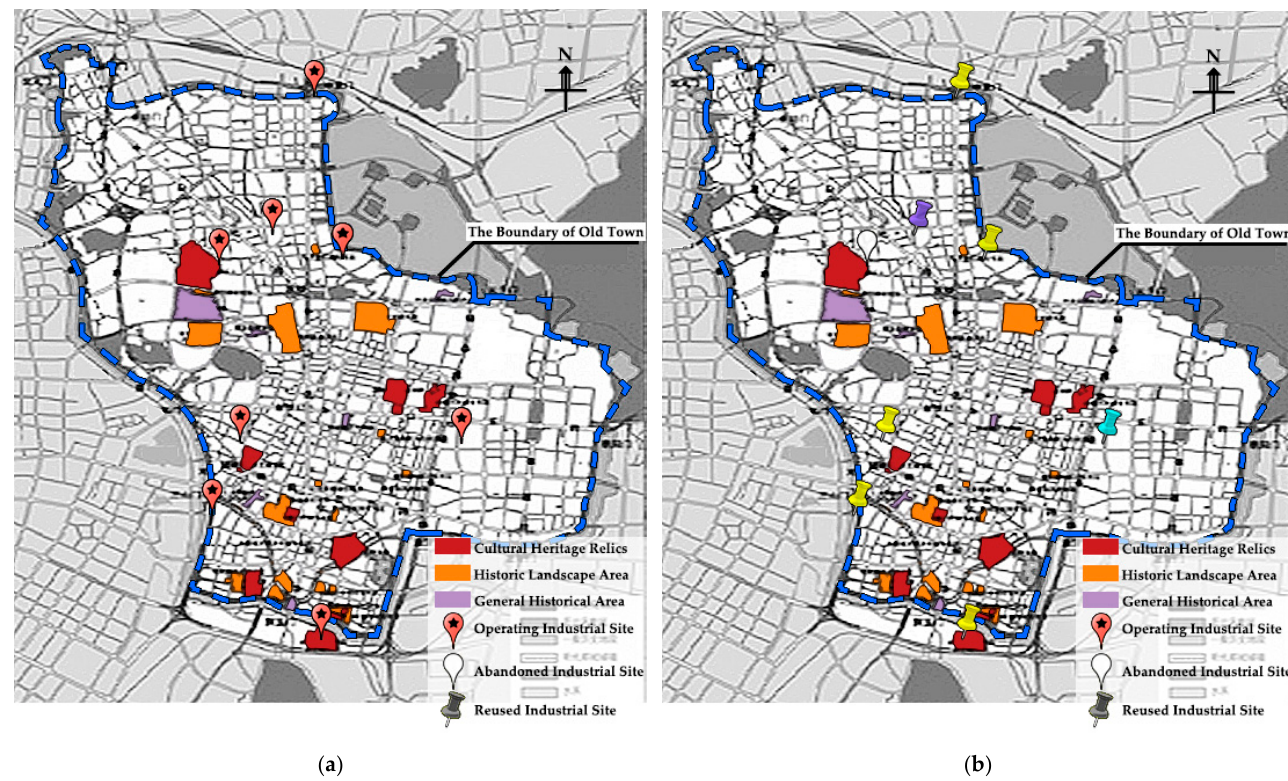
Figure 17. The relationship between the operation state of capital-intensive industries and the cultural heritage relics changing with time: ( a ) 1990; ( b ) 2020. (Figure source: own drawing, data from: [98]).